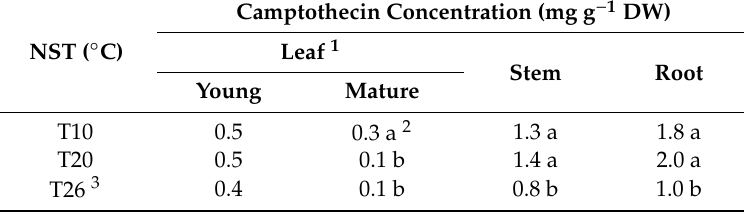
Table 4. E ff ects of nutrient solution temperature (NST) on camptothecin concentrations in O. pumila at 35 days after the start of the treatment (DAT) in experiment 2.